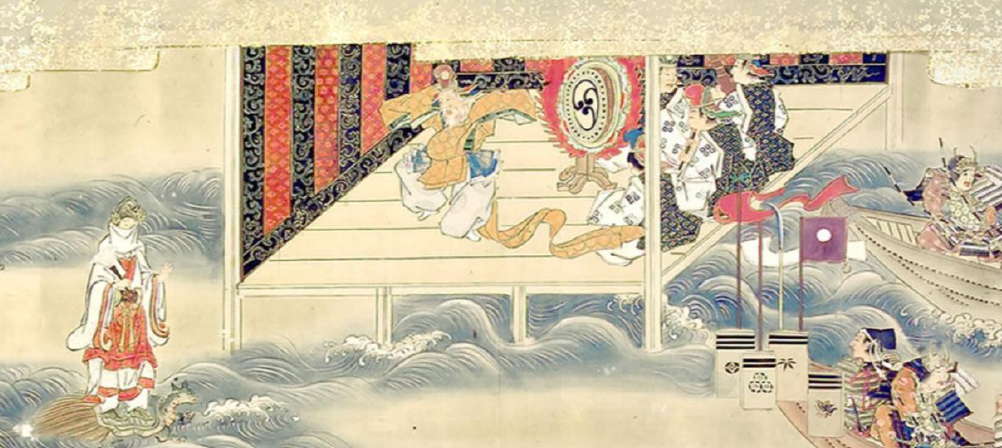
Figure 8. Hachiman Handscrolls (mid-seventeenth century). Smith College Museum of Art. At